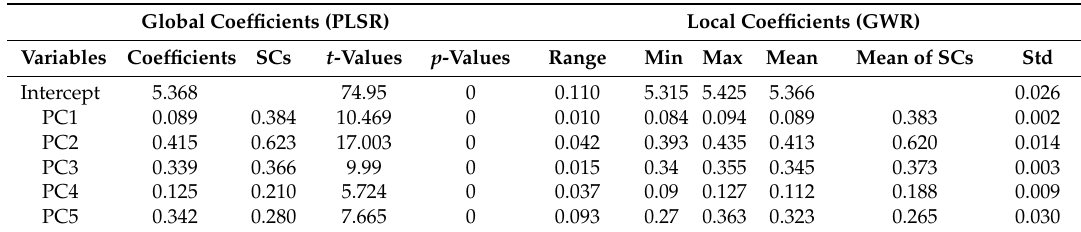
Table 3. Summary of global and local coefficients used in soil organic carbon density (SOCD) model by principal least squares regression (PLSR) and geographically weighted regression (GWR) models.